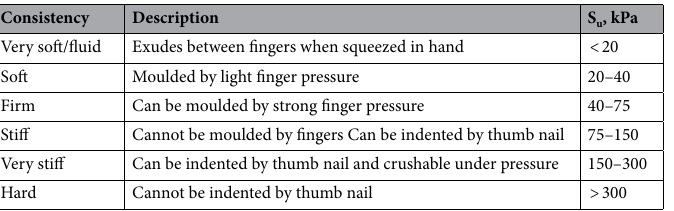
Table 1. Soil consistency classification based on the undrained shear strength, S u of an intact soil 66,67